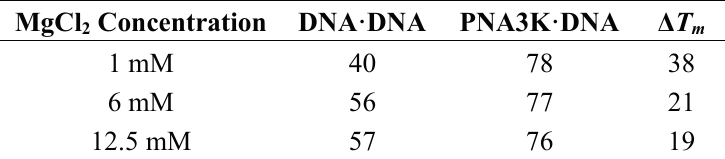
Table 1. Melting temperatures (°C) of homo- and hetero-duplexes in 1× TAE buffer (40 mM Tris acetate, 2 mM EDTA at pH 8.0) and different concentration of MgCl 2